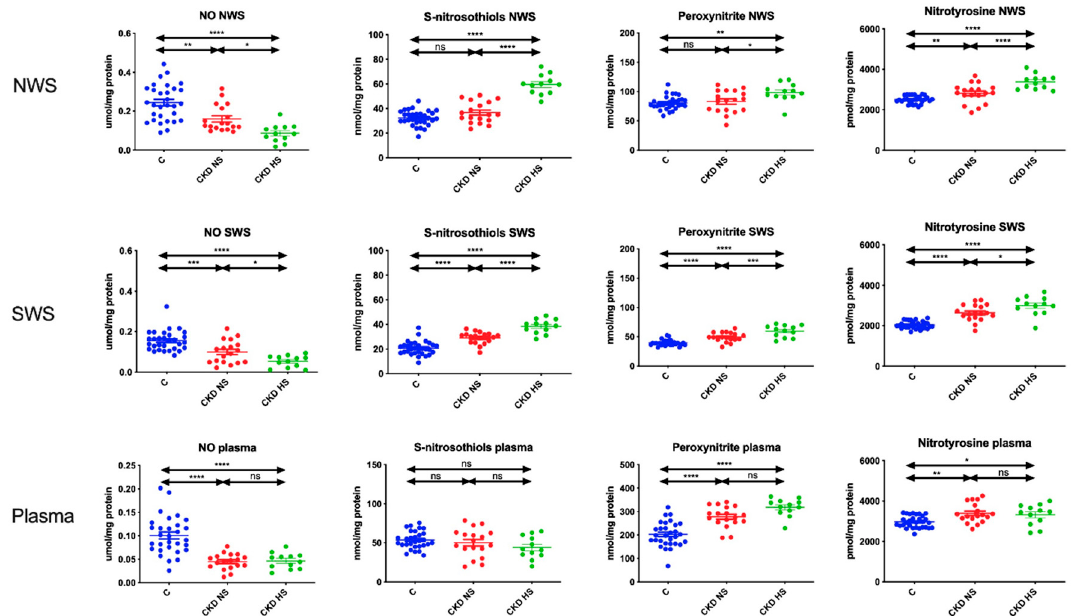
Figure 4. Nitrosative stress in children with chronic kidney disease (CKD) and healthy controls. CKD NS—CKD patients with normal salivary secretion; CKD HS—CKD patients with reduced salivary secretion; NO—nitric oxide; NWS—non-stimulated whole saliva; SWS—stimulated whole saliva.